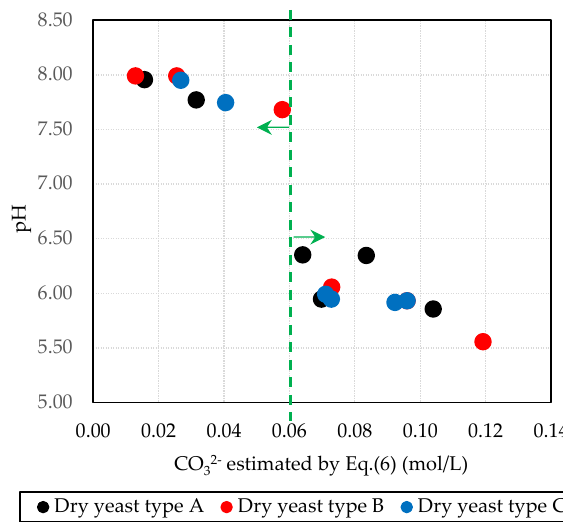
Figure 6. Estimated carbonate ions and pH for up to 48 h (pH 8.0, 0.5.0 mol/L) for all mixtures.